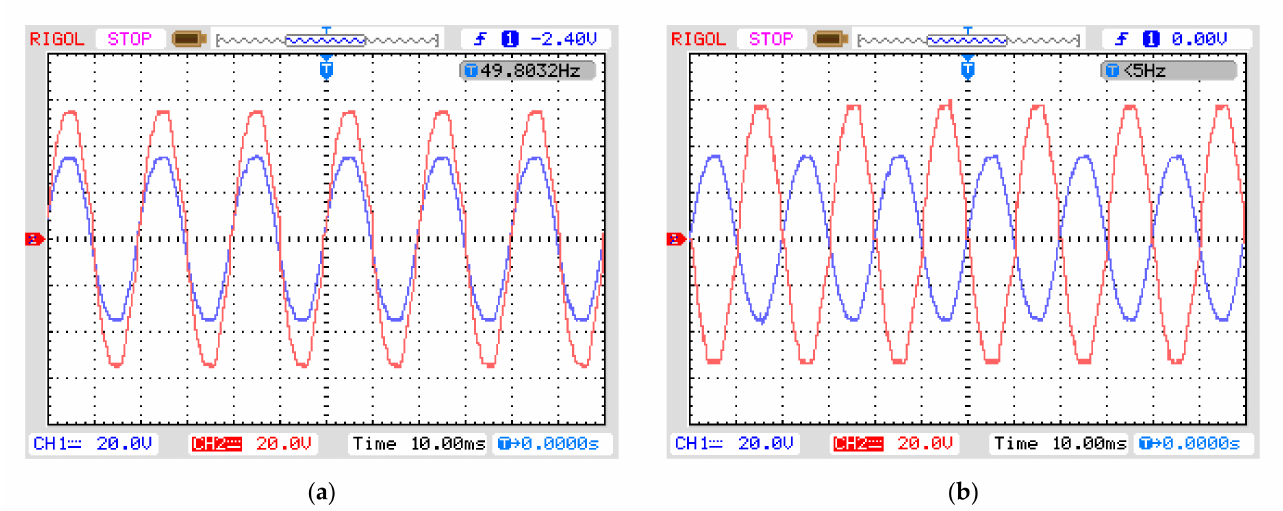
Figure 12. Practically gained waveforms of input (blue) and output (red) for ( a ) non-inverted output and ( b ) inverted